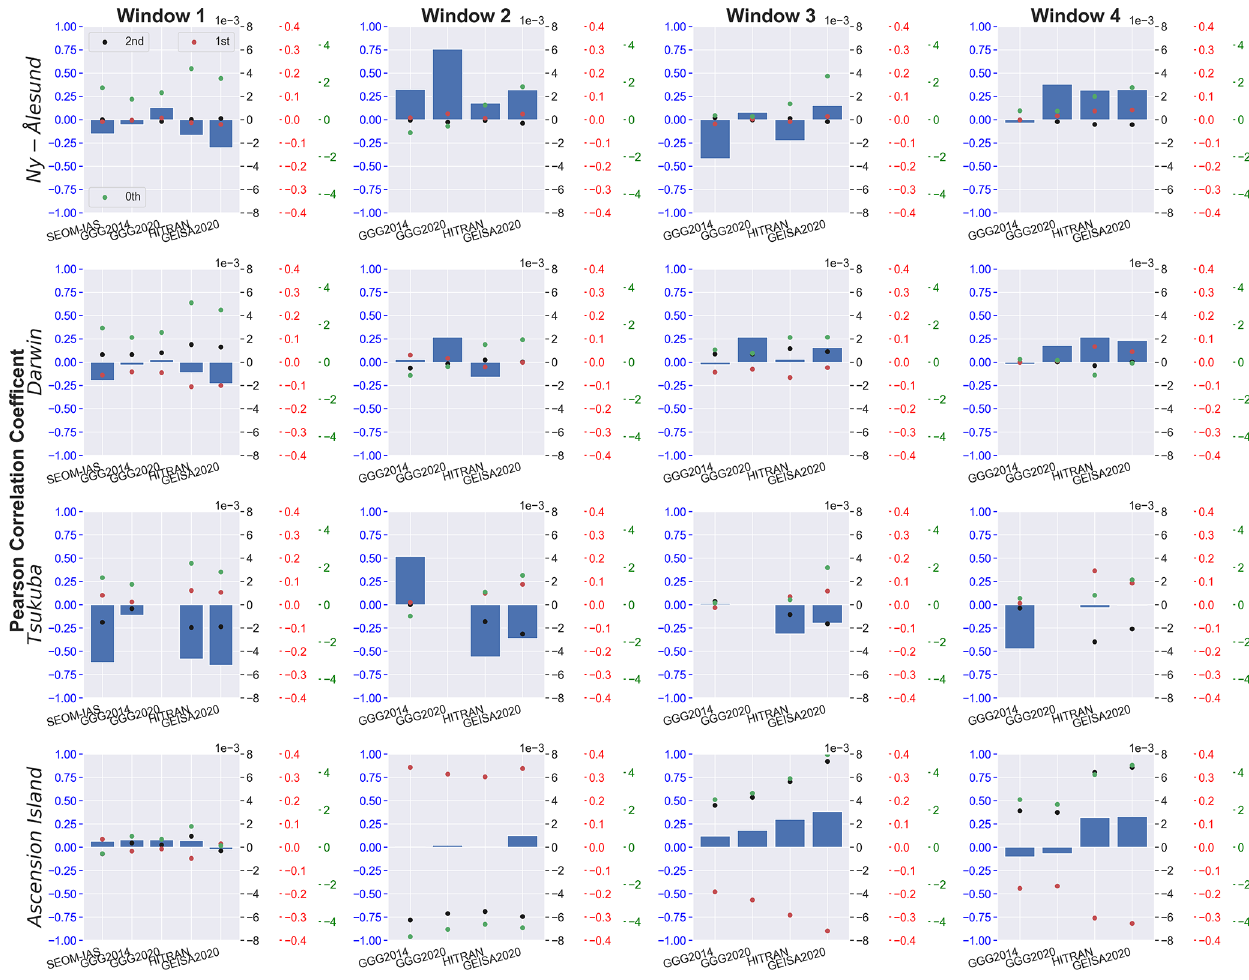
Figure 12. As Fig. 10 but showing the sensitivities to temperature